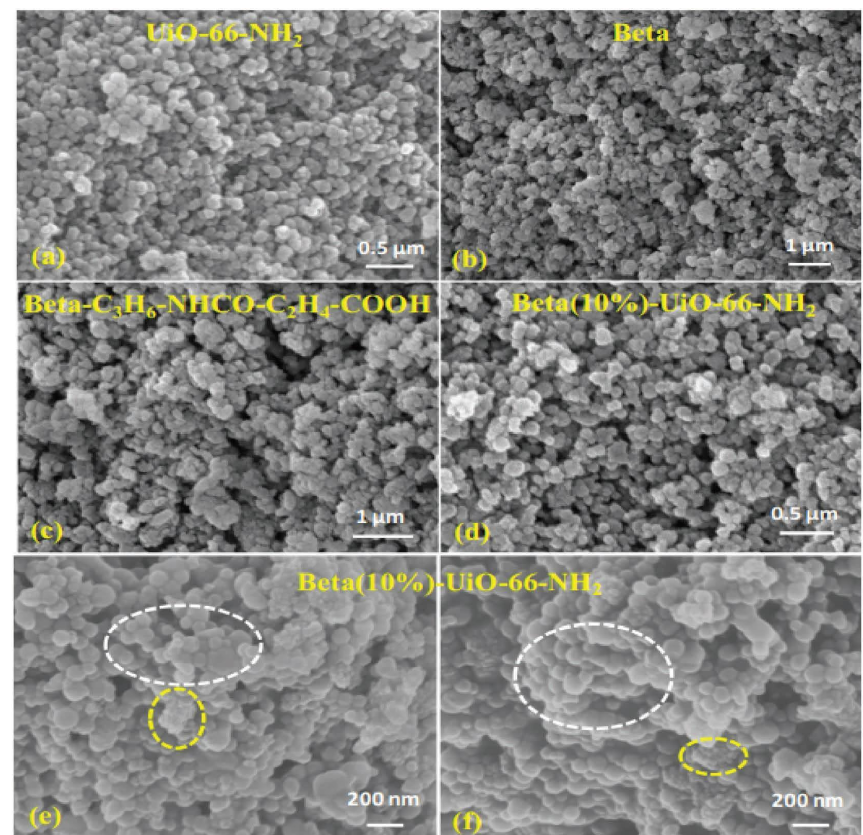
Figure 16: SEM images of parent and composite materials (a–d) and FE-SEM images of Beta (10%)-UiO-66-NH